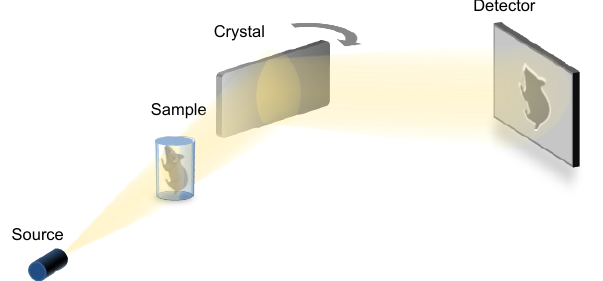
Figure 4. Analyzer-based imaging set-up. A monochromatic beam traverses the sample. Then it arrives on a Laue crystal that only reflects the beam arriving with a precise incident angle toward the detector. The crystal can be rotated to acquire several images with various reflection angles to retrieve the refraction from the